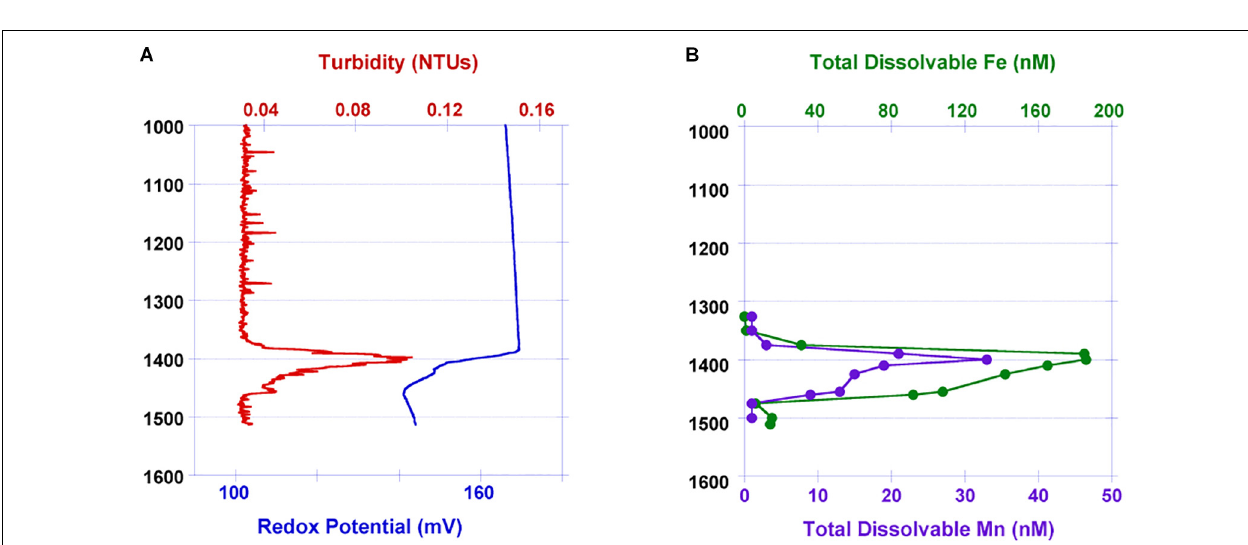
FIGURE 4 | Vertical profiles for (A) Temperature and Salinity and (B) Dissolved Oxygen and Light Transmission above the TH1 summit of Teahitia Seamount from US GEOTRACES CTD Station GP16-37.